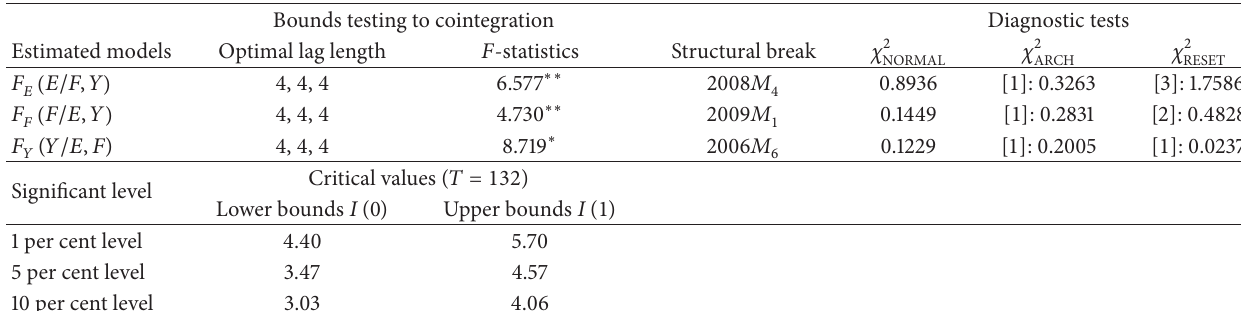
Table 5: The results of ARDL cointegration test.